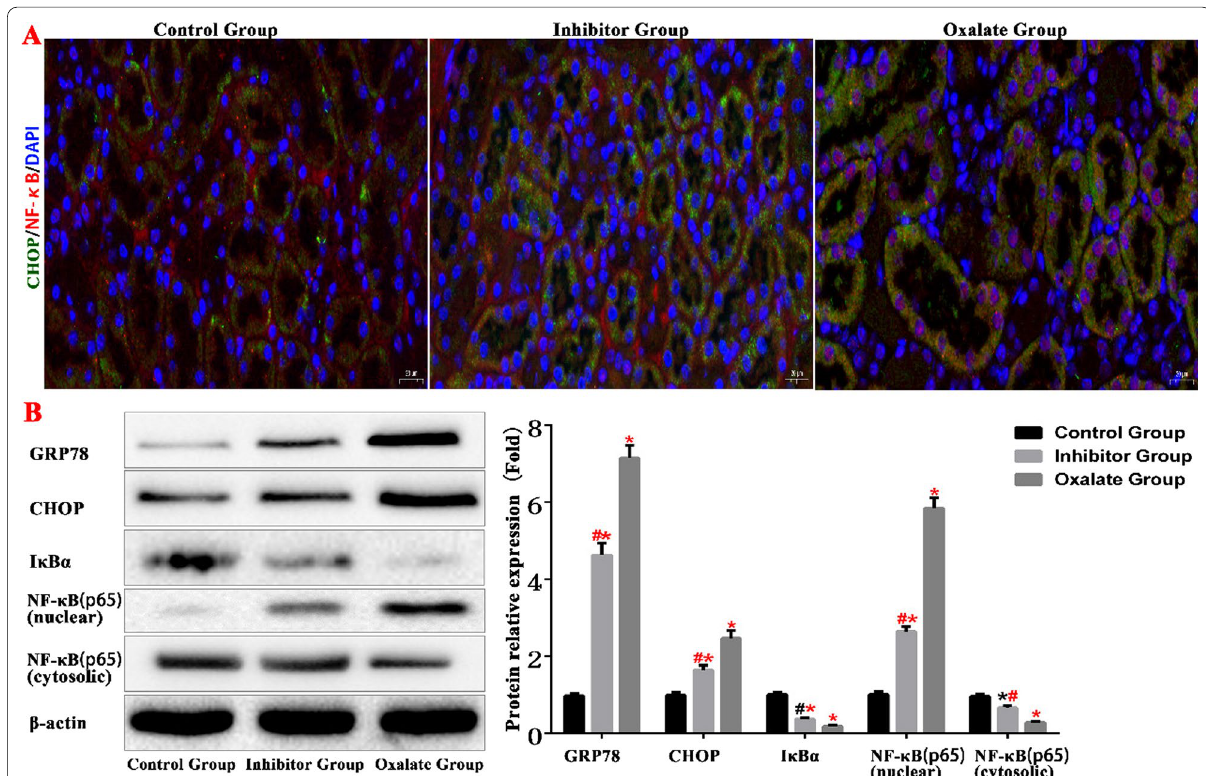
Fig. 7 ERS and NF-κB protein expression level in kidney tissue of mice (*compared with normal Control group, P < 0.05.* (Red) Compared with Control group, P < 0.01. # Compared with oxalate group, P < 0.05. # (Red) Compared with oxalate group, P <